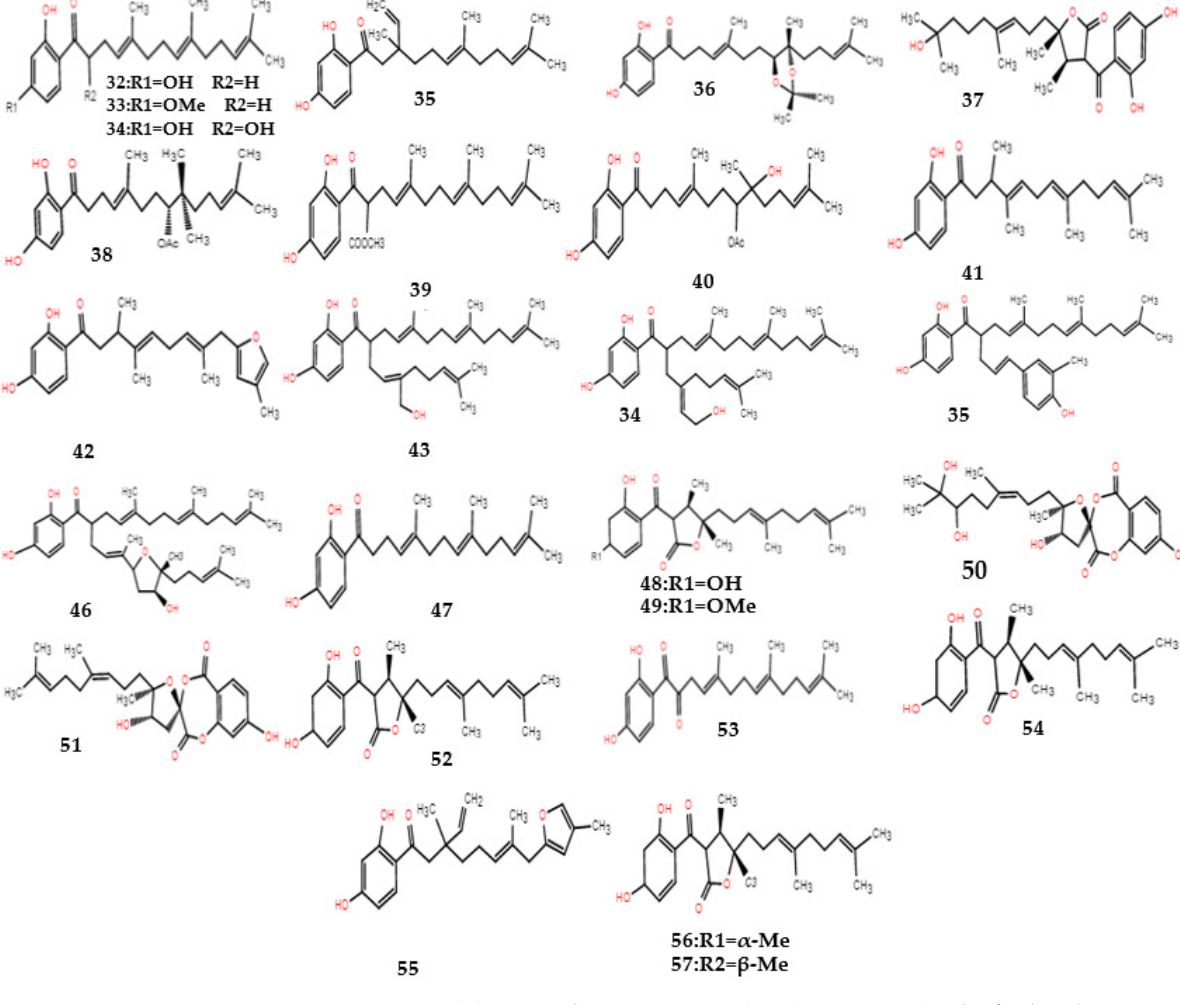
Figure 3. Structural diagram of sesquiterpene–phenolic compounds of F. ferulaeoides .